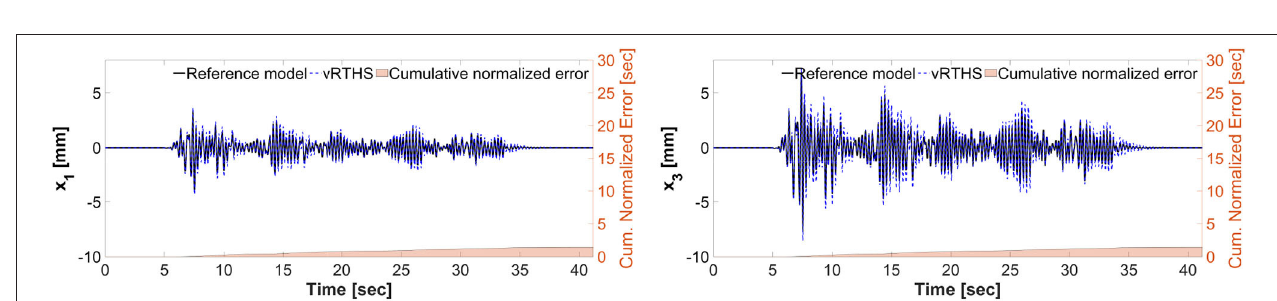
FIGURE 10 | RTHS implementation for benchmark problem by Silva et al. (2020).